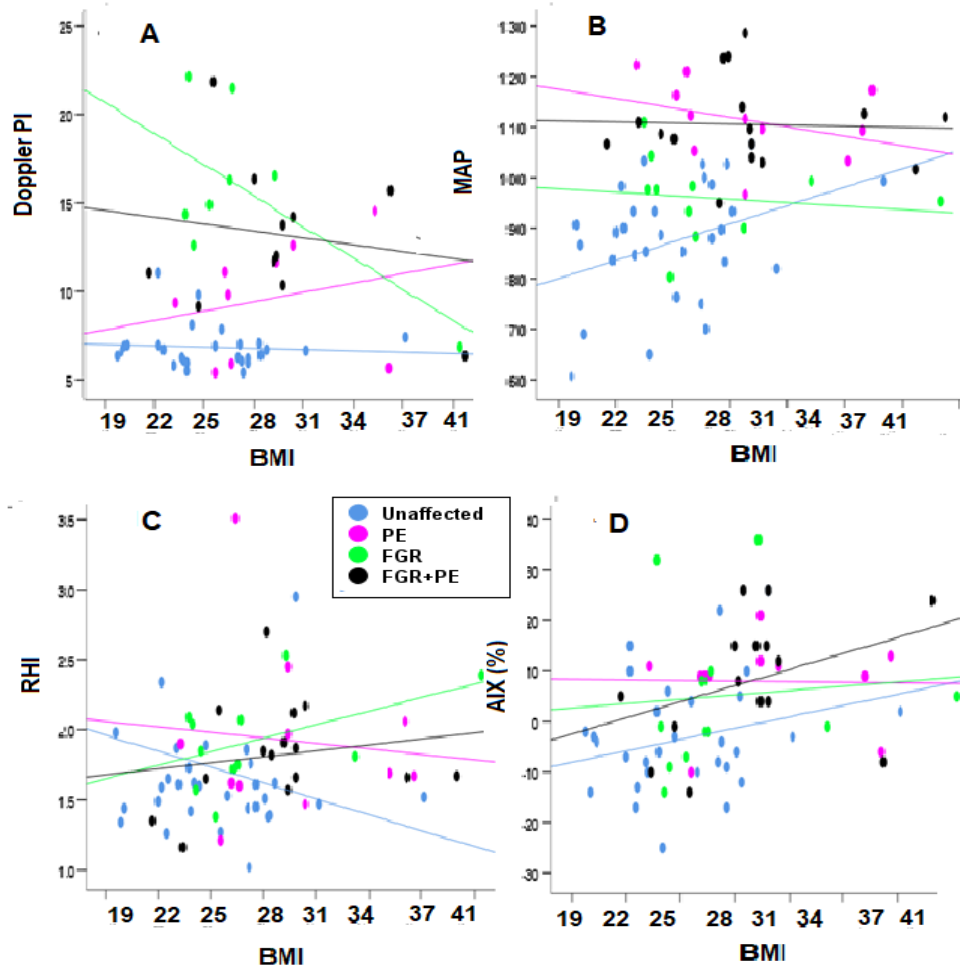
Figure 3. Evaluating the correlation of biophysical markers over BMI. ( A , B ) Mean UtA Doppler PI (Doppler PI in the figure) and MAP; ( C , D ) RHI and AIX%. Blue—unaffected group, purple—PE, green—FGR, and black—PE + FGR.